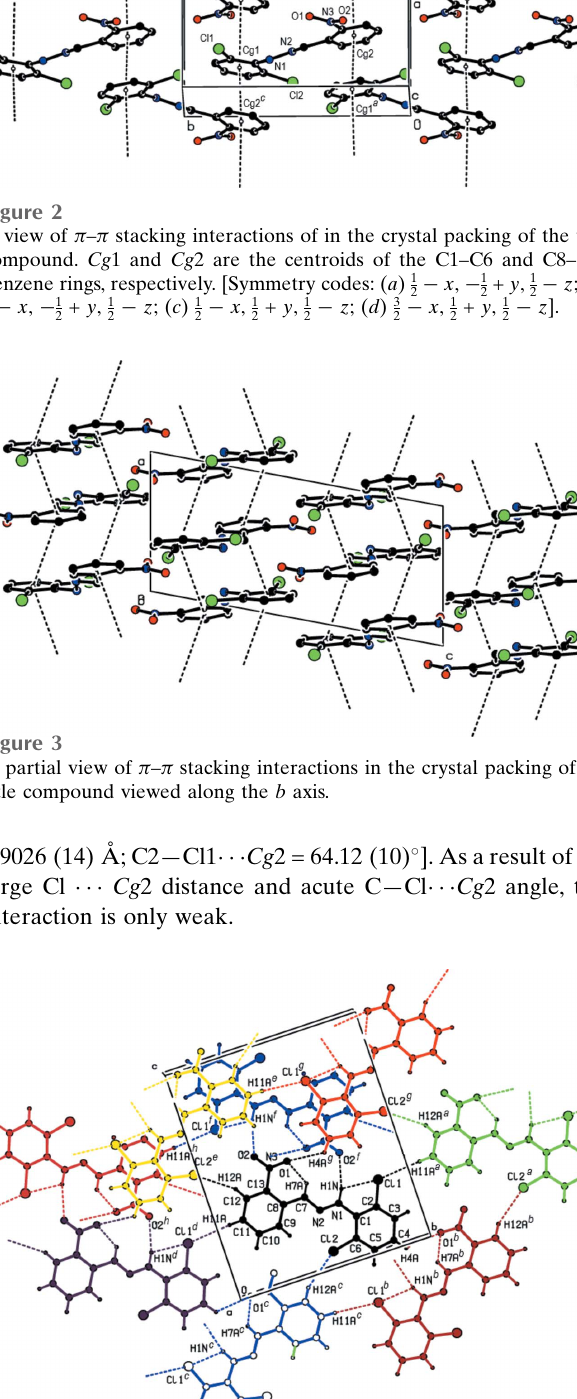
(cid:4) y , (cid:4) 1 + x , 3 + z ; 2 2 2